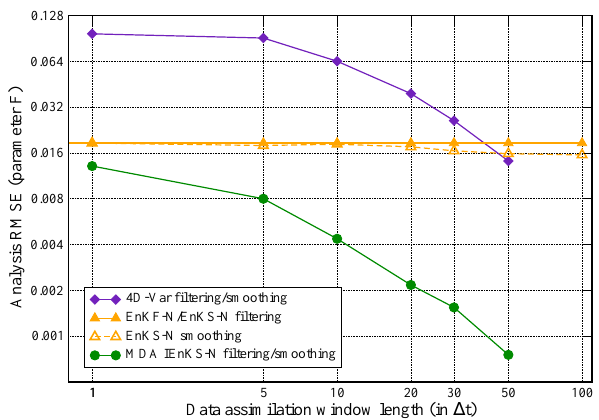
Fig. 5. Plot of the Lorenz ’95 forcing parameter F as a function of the cycle index of the data assimilation experiment. F is es- timated by several filters and smoothers with an ensemble of size N = 20 . The forcing of the true model is F = 8 . The MDA IEnKS Fig. 6. Root mean square errors for the analysis of the state vector for L = 1 , 5 , 10 and 30 is compared to the EnKF and the EnKS at present time (filtering) or the retrospective analysis of the state ( L = 50 ). The finite-size variants of these methods are used: they vector (smoothing) for the EnKF, EnKS and the IEnKS, in the case do not require inflation and perform, in this context, as well as with of the Lorenz ’95 model, with ∆ t = 0 . 05 . optimally tuned inflation.